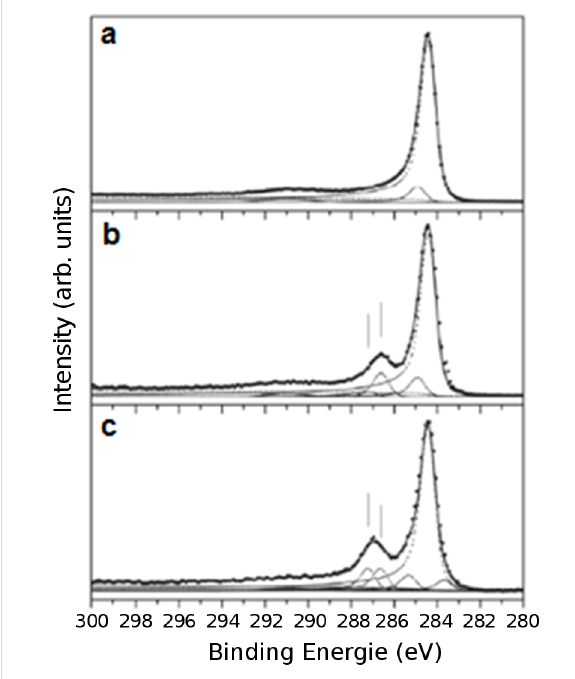
Figure 10: XPS analysis of (a) pristine vertically aligned MWCNTs and oxygen-plasma-treated MWCNTs for (b) 5 min and (c) 30 min. Vertical lines indicate the components associated with the oxygen functional- ization. Adapted with permission from [102]. Copyright 2011 American Chemical Society.